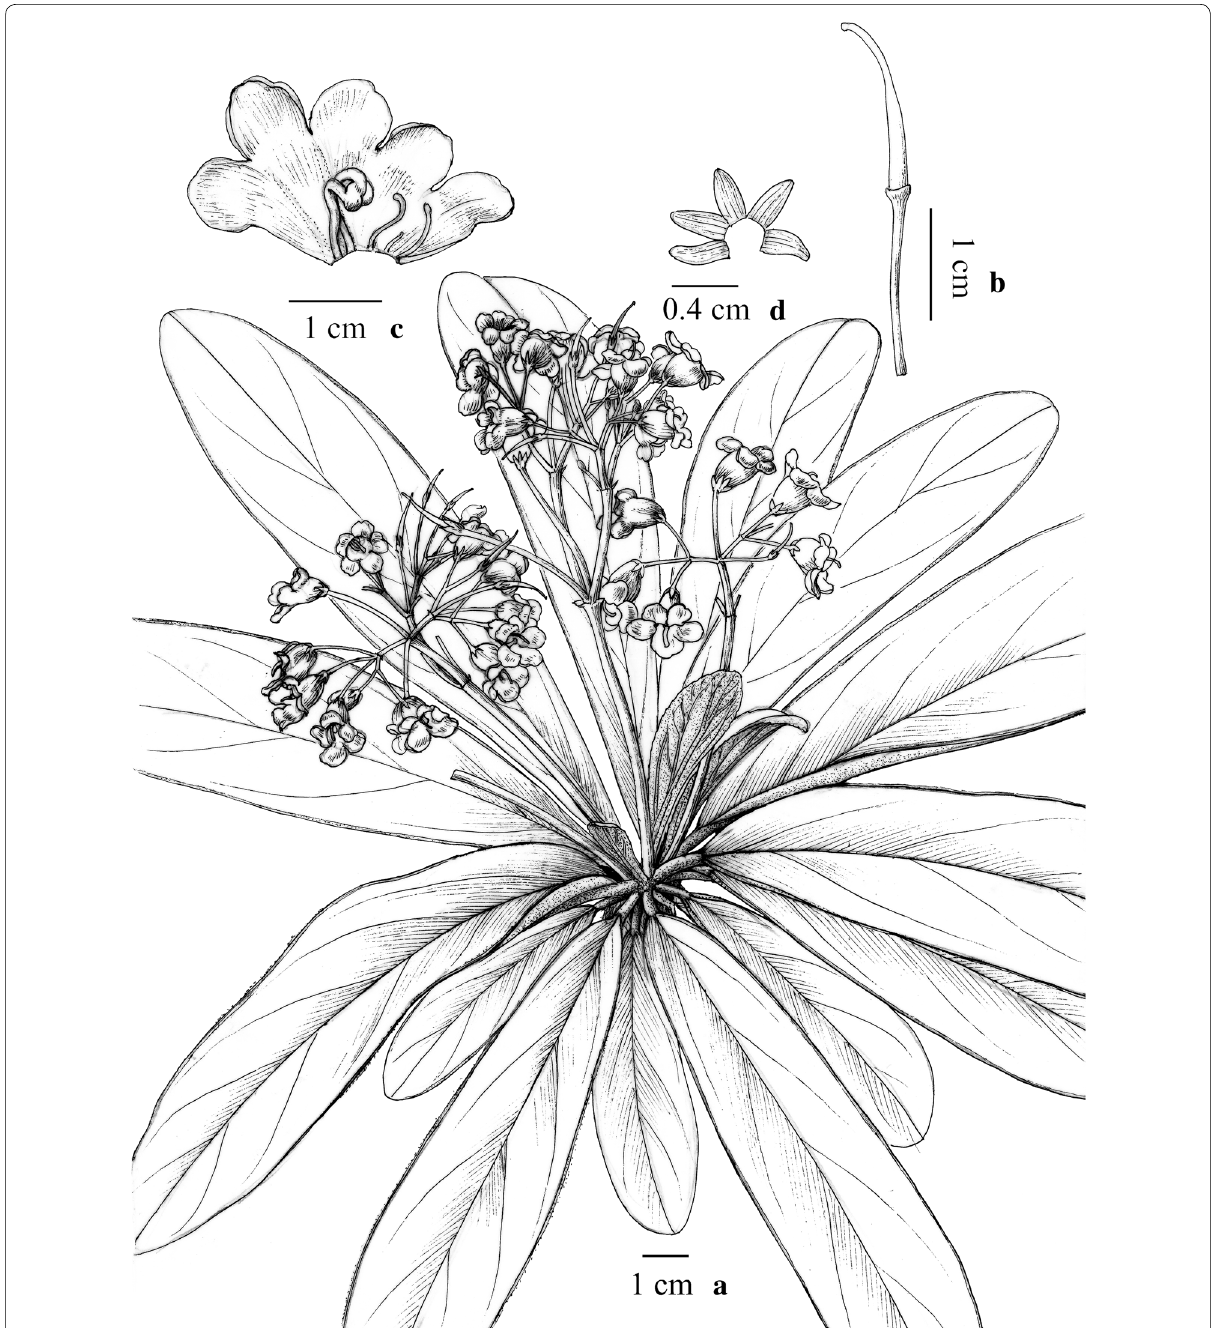
Fig. 6 Paraboea xiangguiensis W.B.Xu & B.Pan. a Habit; b pistil; c opened corolla showing stamens and staminodes; d calyx (Drawn by W.H. Lin from the